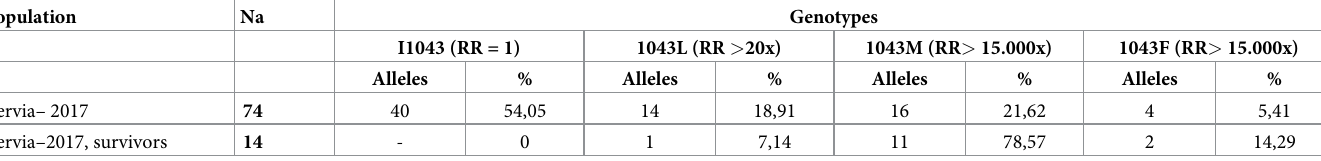
Na = total number of alleles; survivors = individuals that survived a diflubenzuron dose of 0,468 ppm. R.R = The Resistance Ratio to diflubenzuron conferred by each allele (in homozygosity) when introduced with CRISPR/Cas9 in Drosophila melanogaster . The frequency of mutated alleles was significantly higher (p-value < 0.0001, Fisher’s test) in bioassay